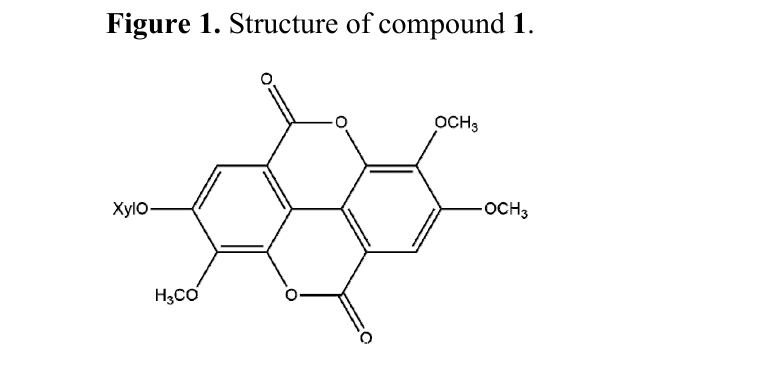
, δ (ppm), J in Hz]. 6